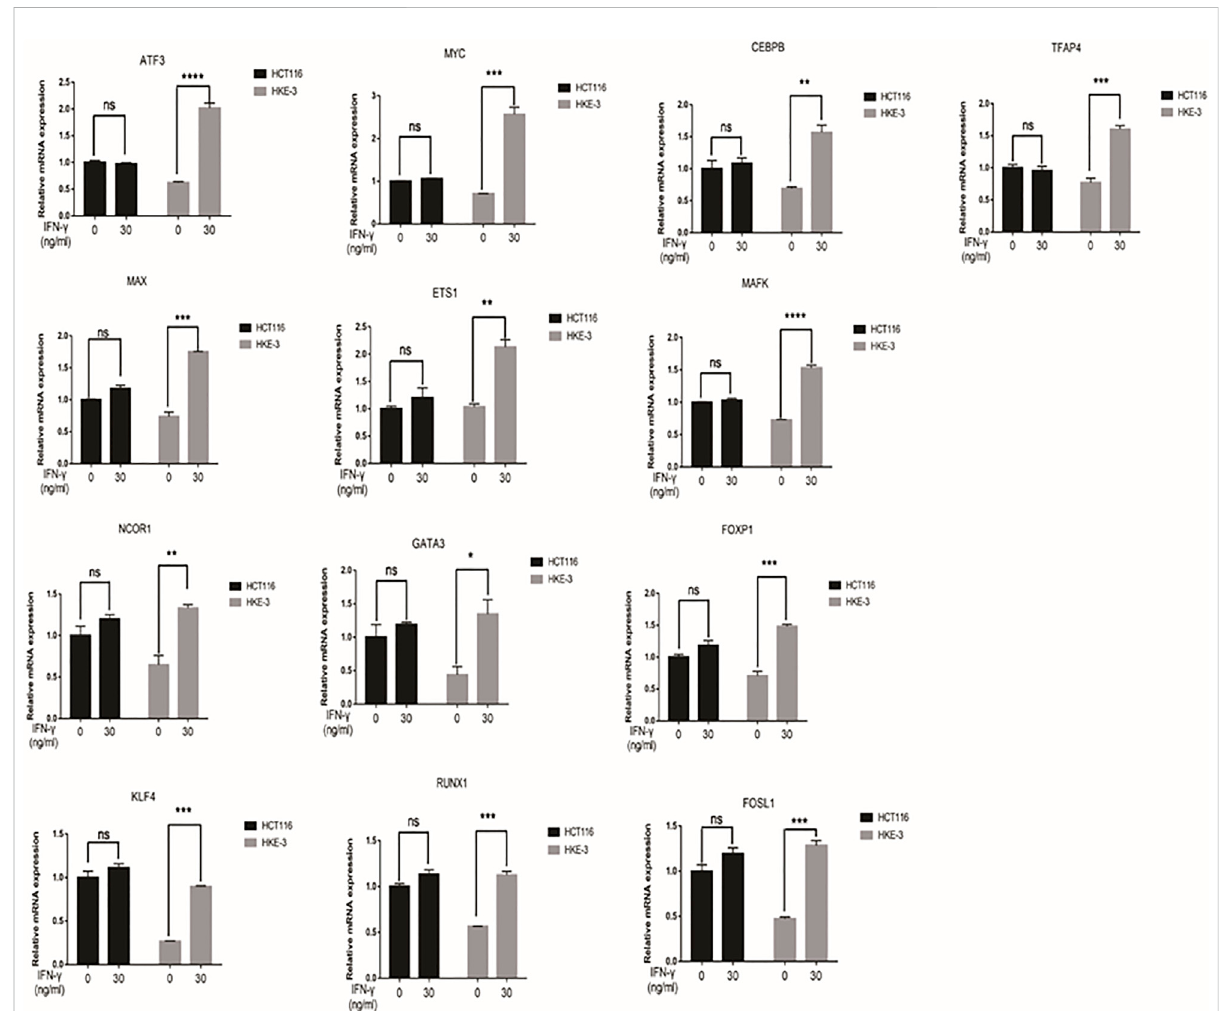
The mRNA expression of selected 13 transcription factors were upregulated by IFN- γ in HKE-3 cells. After being treated with IFN- γ , the mRNA expression of 13 transcription factors in HCT116 or HKE-3 cells was detected by RT-PCR analysis. * p < 0.05, ** p < 0.01, *** p < 0.001, and **** p < 0.0001 vs. no IFN- γ